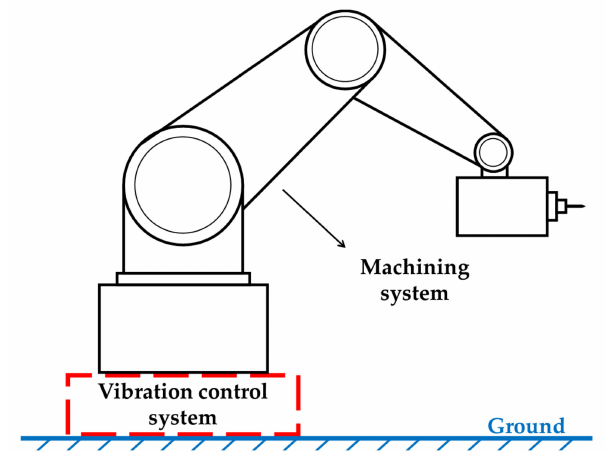
Figure 1. Structural sketch of a robotic machining system.